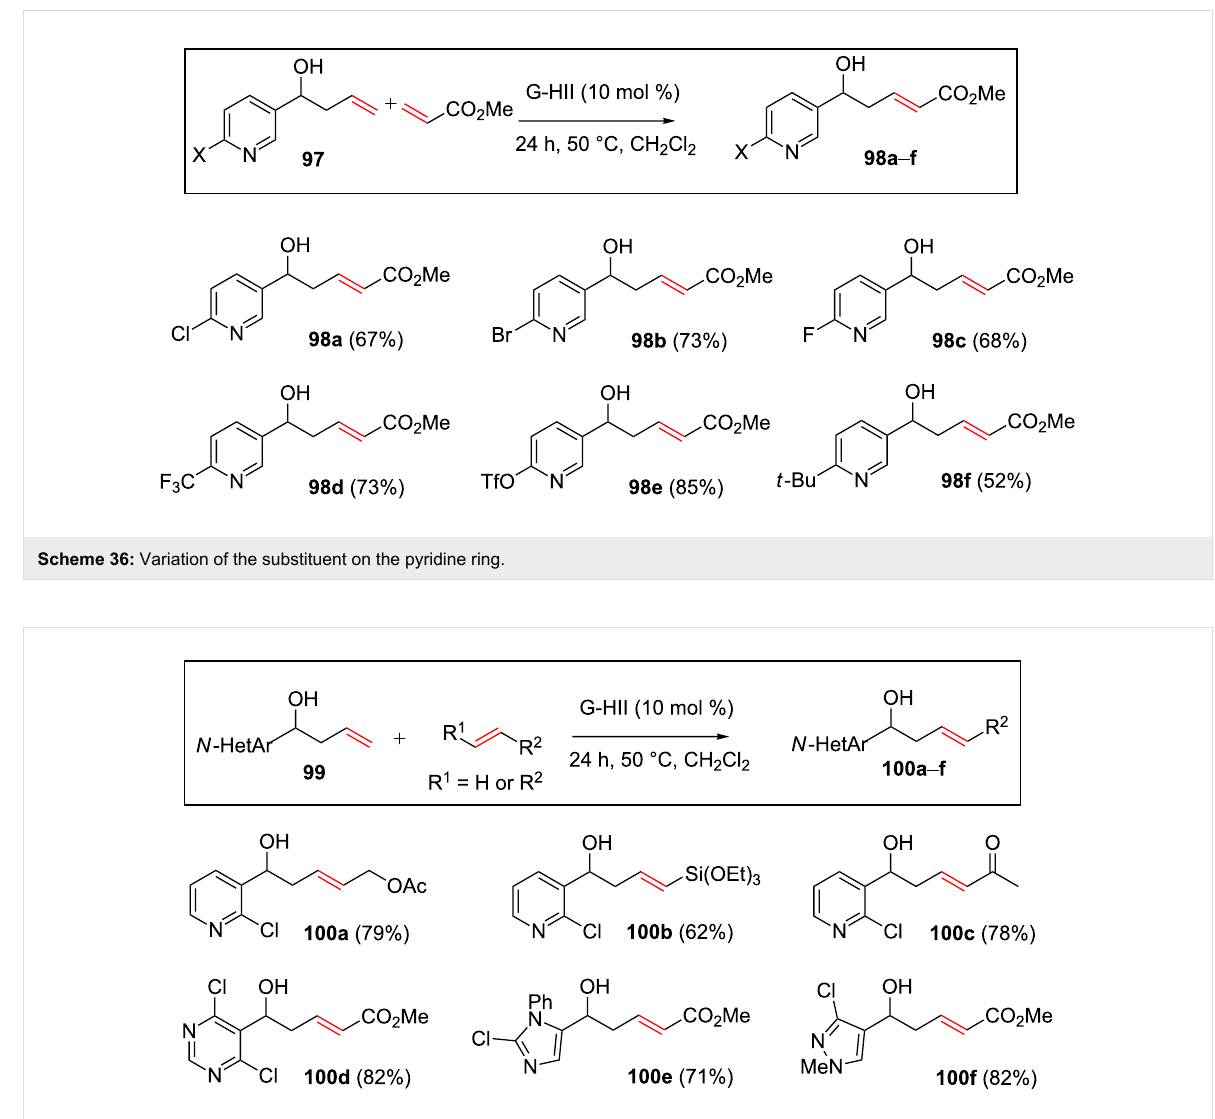
Scheme 37: CM involving alkenes containing a variety of N